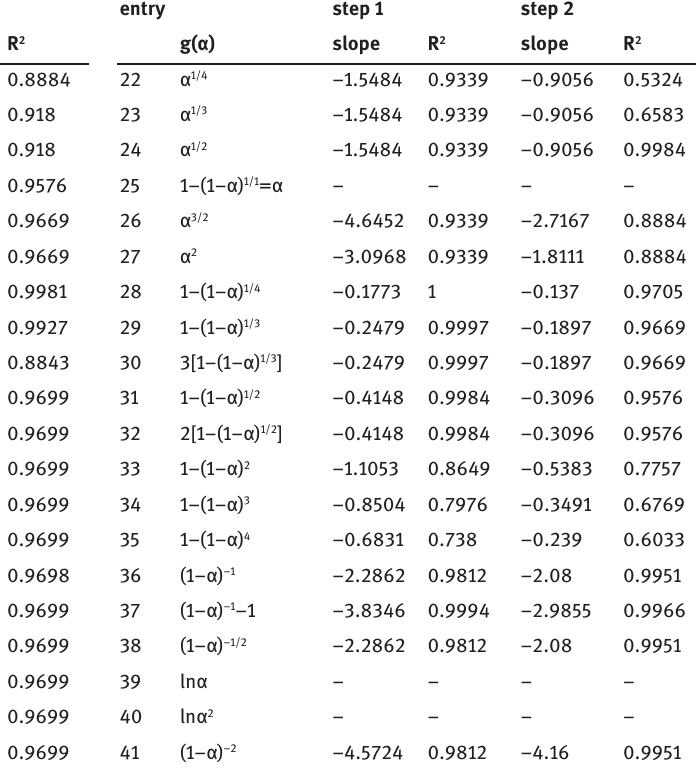
Figure 3: Differential thermal analysis (DTA) curve of NPL-10.